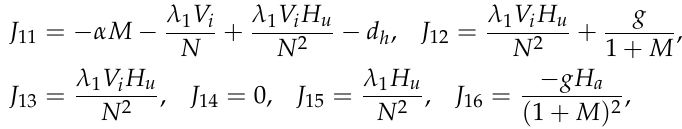
Figure 3. Numerical solution of the system (1) with and without the impact of awareness.